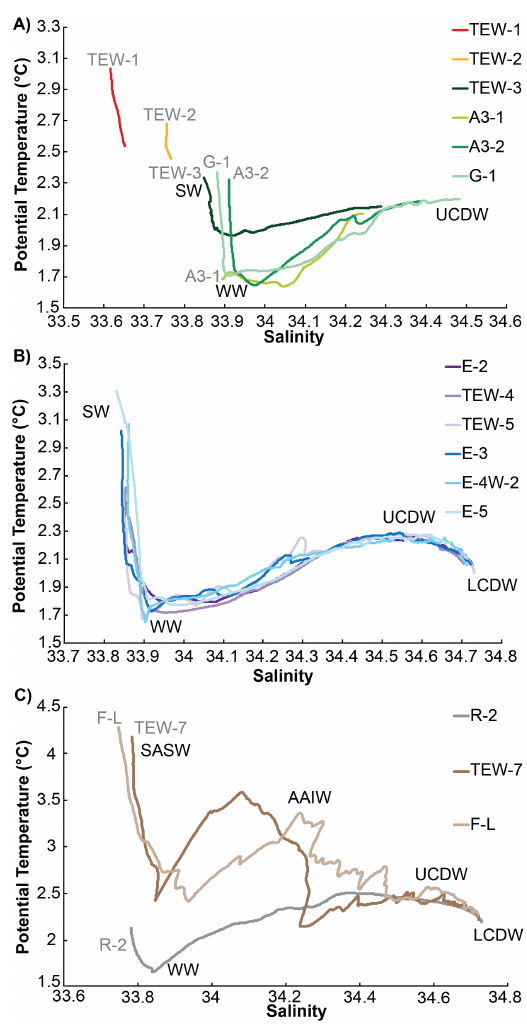
Figure 2. Potential temperature–salinity diagram for stations sam- pled during KEOPS2 for dissolved iron. Water masses are indicated in black, and station names in grey. The same colour code as used in Fig. 1 applies here. (a) Clusters 1 and 2: near-coastal (TEW-1, TEW-2) and Kerguelen Plateau (A3-1, A3-2, G-1, TEW-3) stations. Three water masses are displayed: surface water (SW), winter wa- ter (WW), Upper Circumpolar Deep Water (UCDW). (b) Cluster 3: the recirculation area (E-2, TEW-4, TEW-5, E-3, E-4W-2, E-5). Four water masses are displayed: surface water (SW), winter water (WW), Upper Circumpolar Deep Water (UCDW), Lower Circum- polar Deep Water (LCDW). (c) Clusters 4 and 5: north of the polar front (F-L, TEW-7) and the HNLC area (R-2). Five water masses are displayed: Subantarctic Surface Water (SASW), Antarctic Interme- diate Water (AAIW), winter water (WW), Upper Circumpolar Deep Water (UCDW), Lower Circumpolar Deep Water